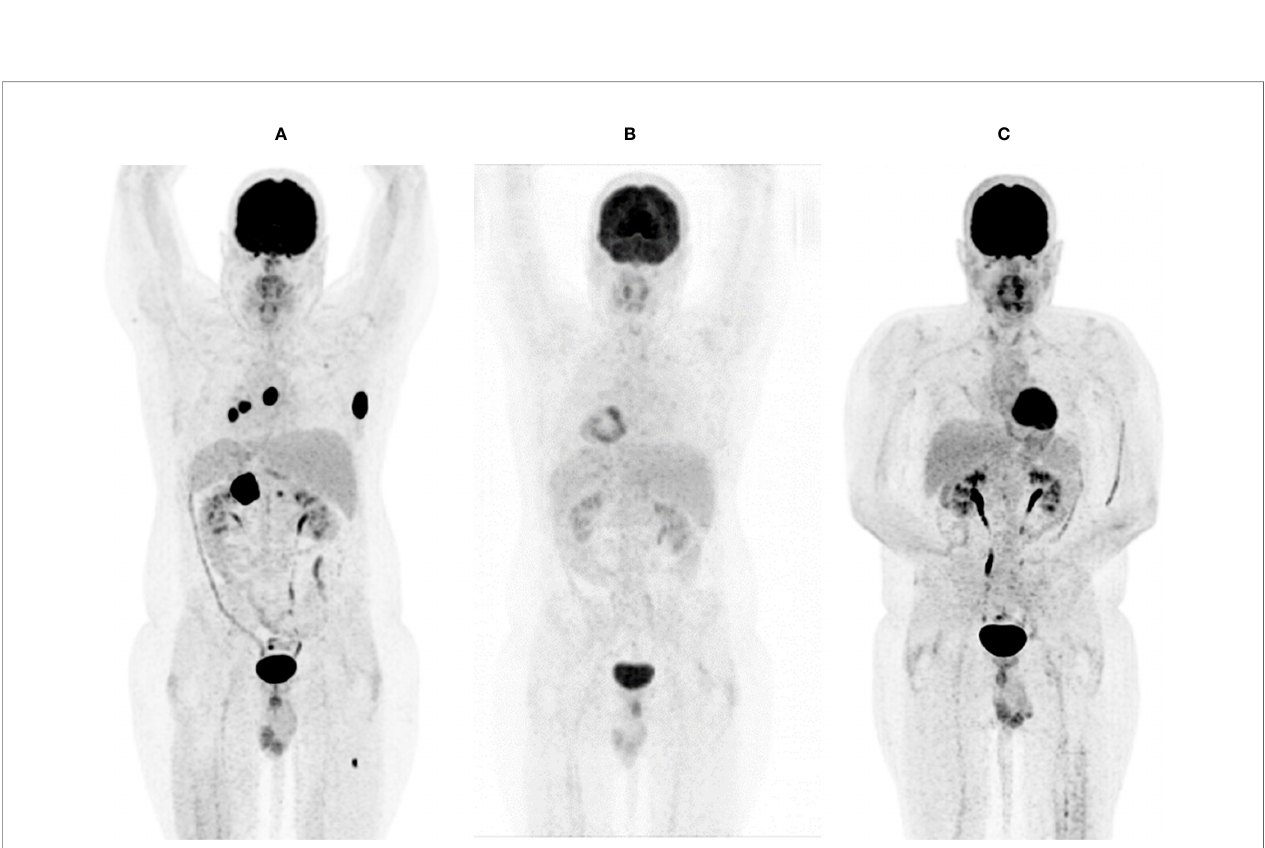
FIGURE 2 | FDG-PET-CT showing systemic metastasis before (A) , after three months (B) , and after one year (C) of double check point inhibition with ipilimumab and